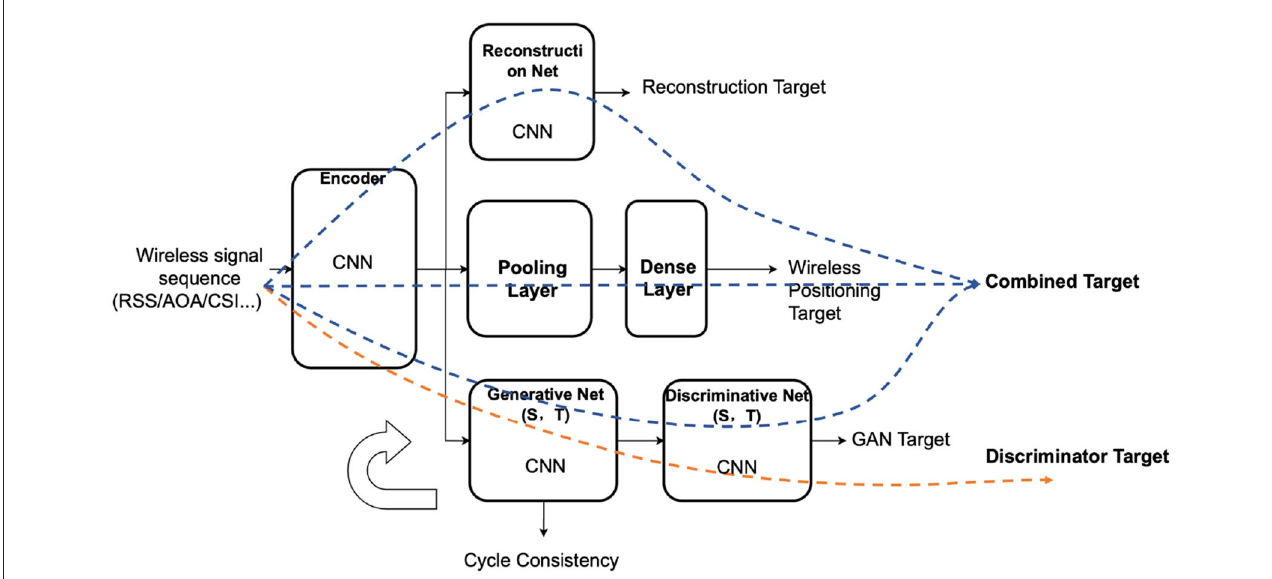
FIGURE5 Transfer learning structure of wireless positioning encoder in